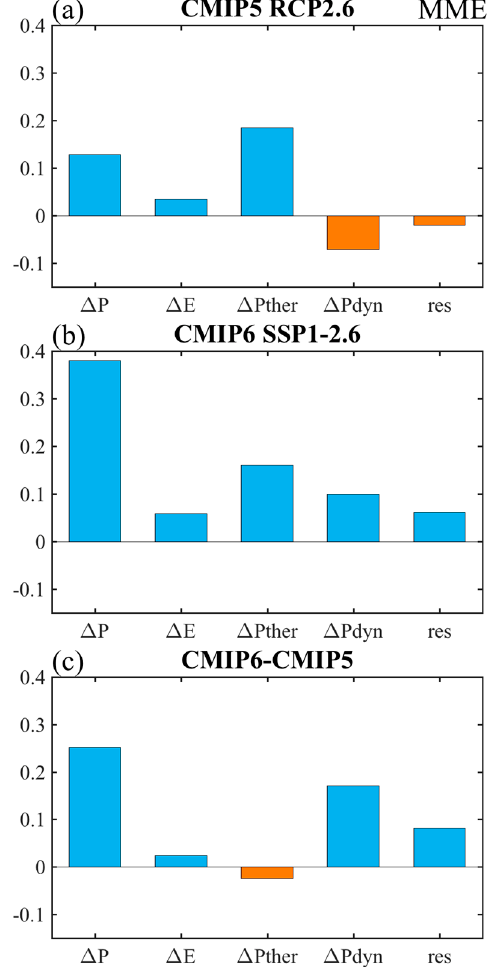
Figure 5. Histograms for area-weighted-mean (65–90° E and 10–30° N, regions indicated by the black boxes in Figures 2–4) MME ISM precipitation (mm day − 1 ) and its subcomponents under ( a ) RCP2.6 and ( b ) SSP1-2.6 and ( c ) their differences.